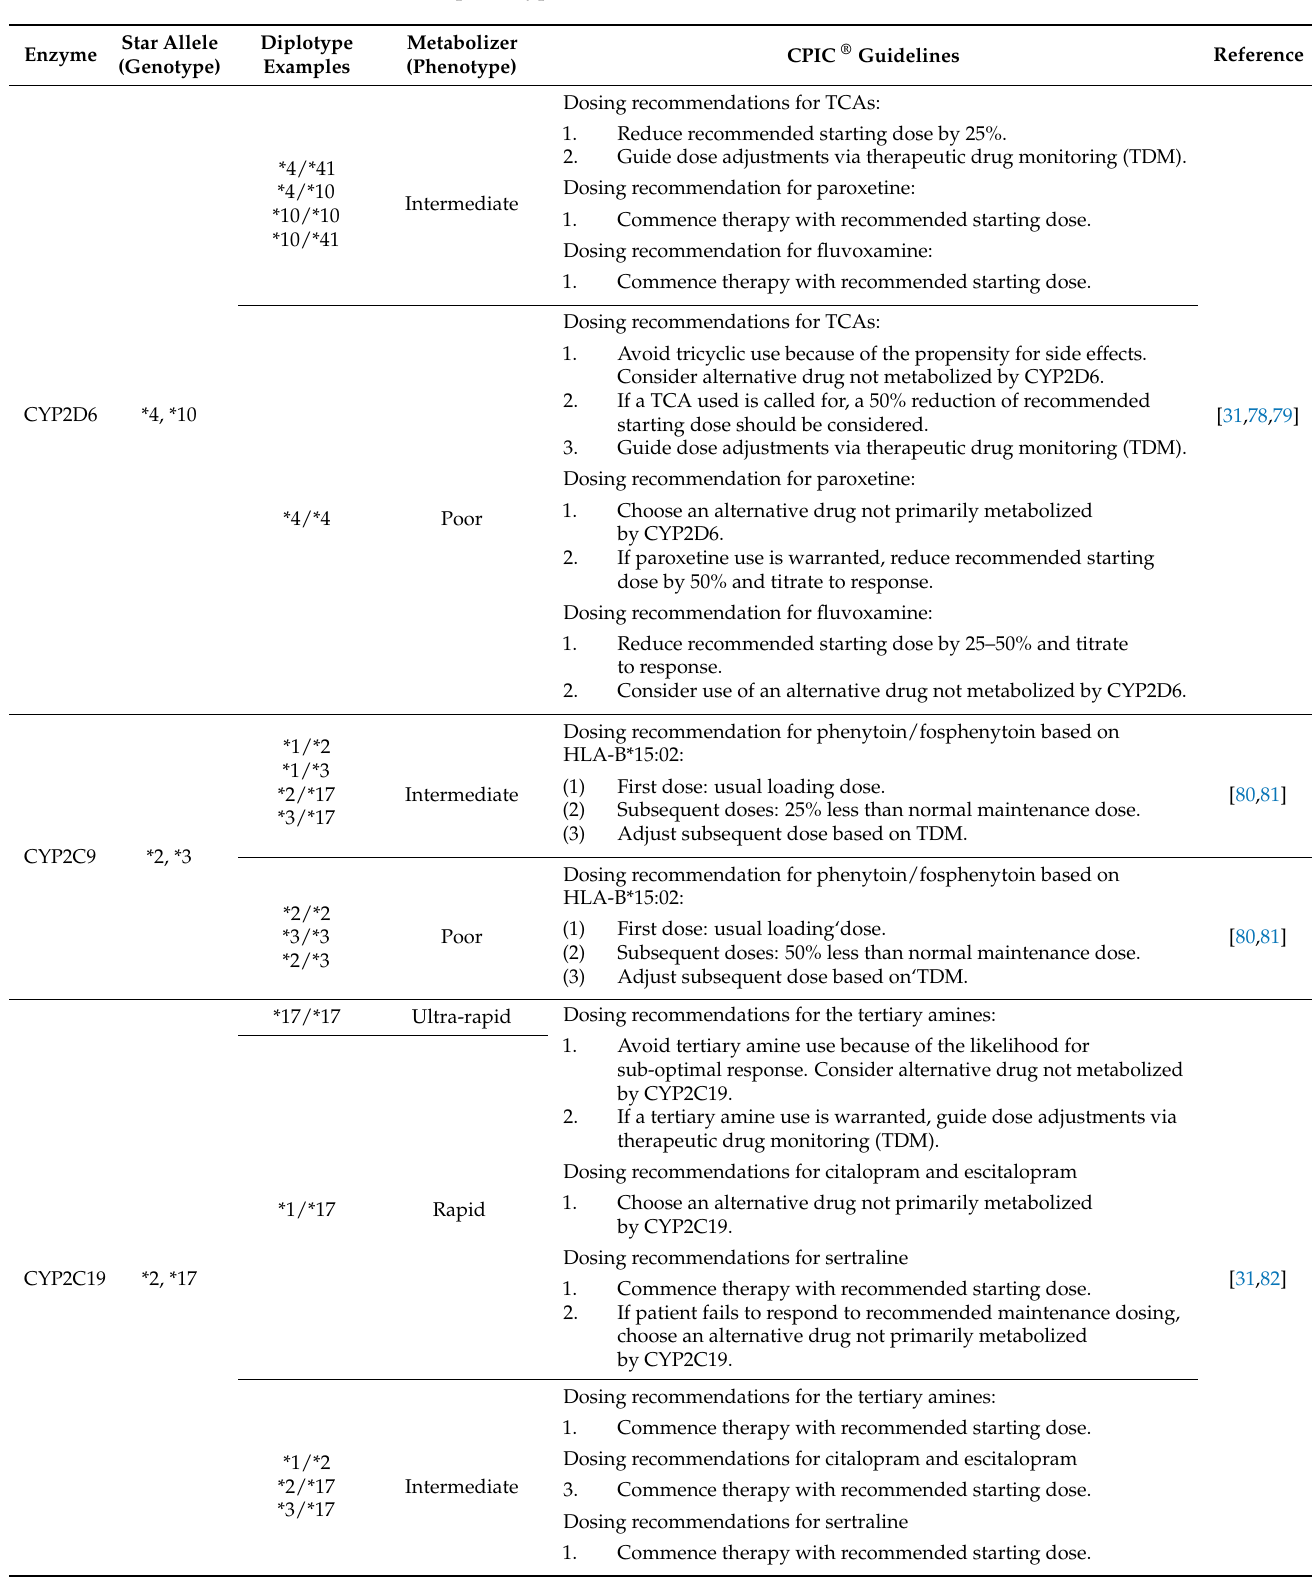
Table 3. Dosing recommendations for psychotropic drugs based on CPIC guidelines for selected CYP and HLA-B